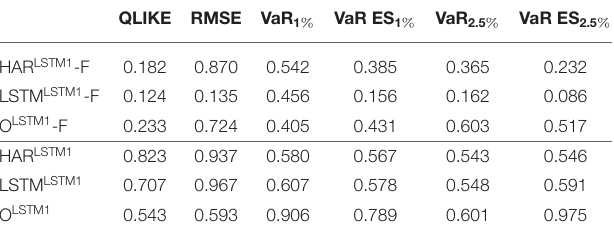
TABLE 3 | p -values of SPA tests for the LSTM1 against the alternative transformations.